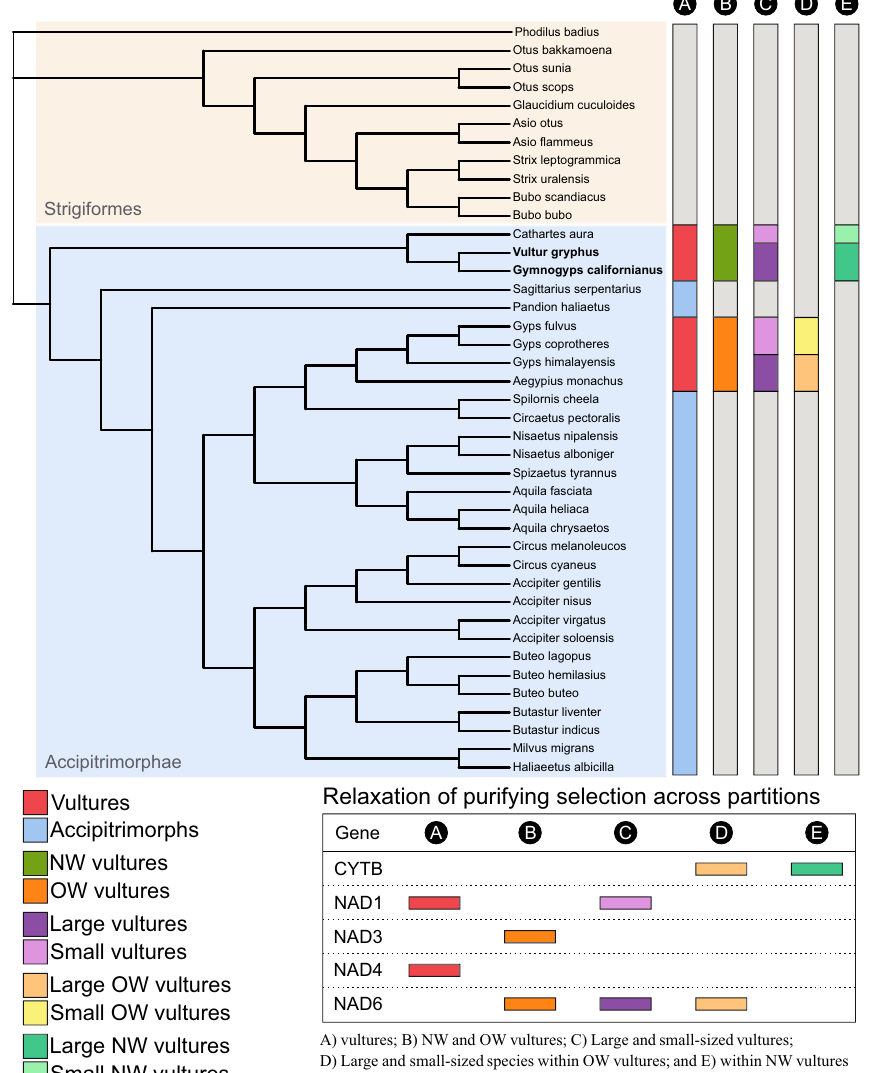
Figure 4. Phylogenetic tree of raptors (Afroaves clade), based on mitochondrial PCGs. Clade partitions (comparisons) are denoted with letters ( A – E ), while colored bars indicate target groups of the clade model analysis. The bottom table summarizes the results of genes exhibiting significant selective relaxation for each partition. The tree was obtained with FigTree 1.4.4 (https:// anaco nda. org/ bioco nda/ figtr ee) and the figure was edited with Inkscape 1.1 (http:// www. inksc ape.